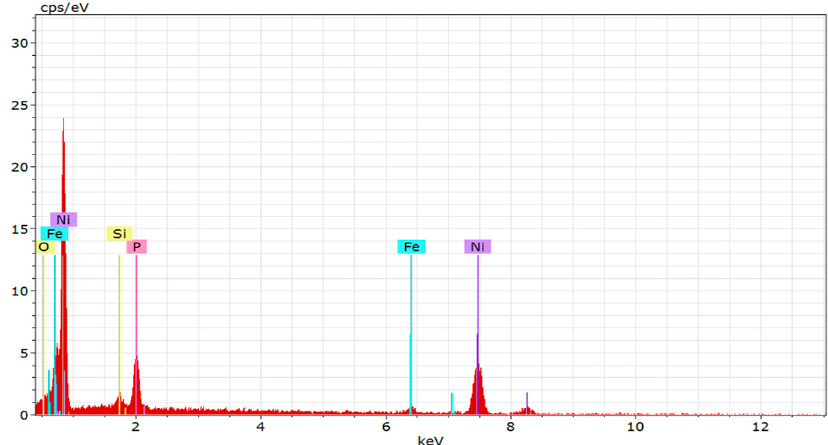
Figure 3. A close-up BSE image of the micrometeorite grain in Figure 2, with EDS analysis (below). The blurry image is due to extremely small grain-size, taken at the lower limit of SEM resolution. Sample RIC 3.